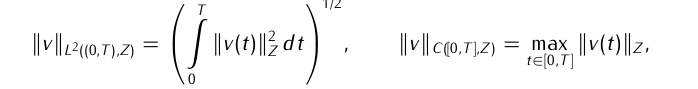
Figure 2. Microchannel with three inflow boundaries enter the